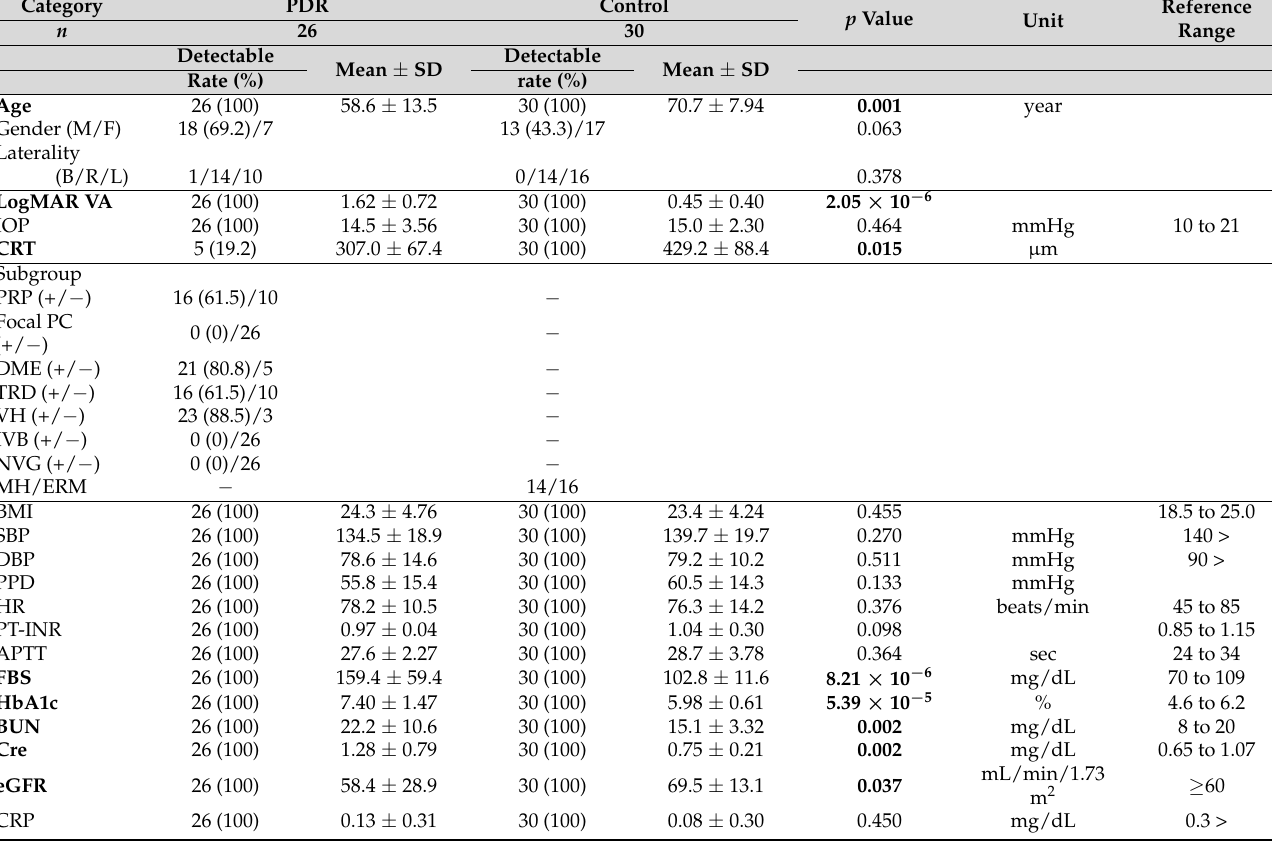
Table 1. Demographic and clinical data of PDR patients and